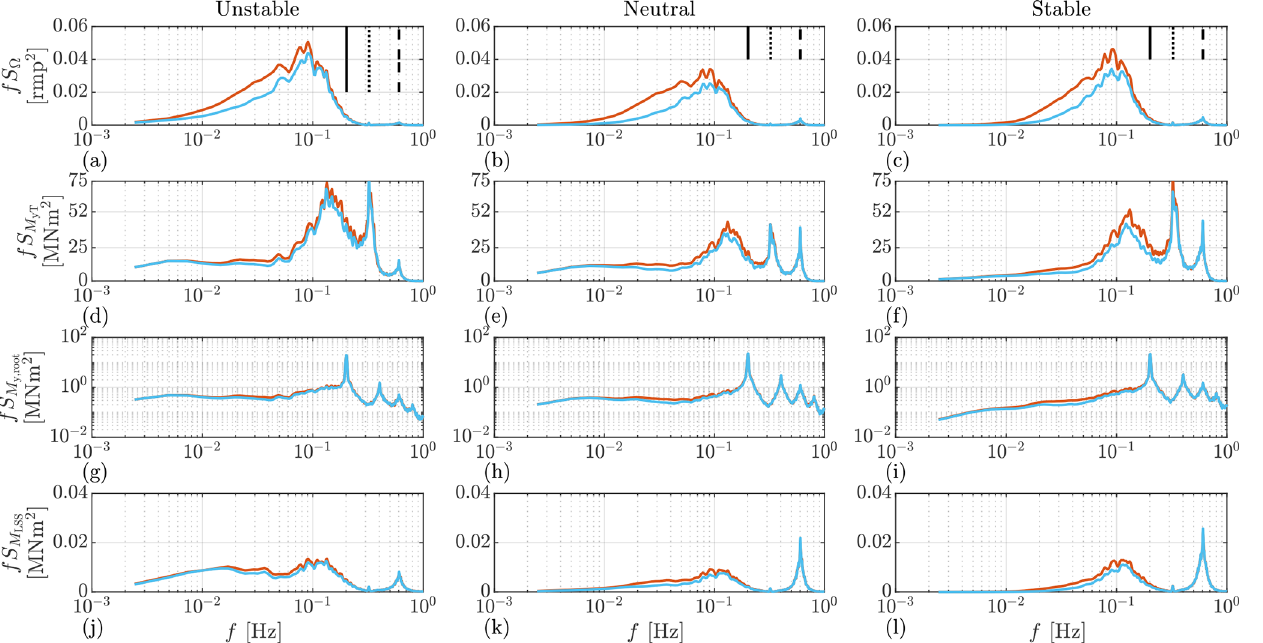
Figure 12. The auto-spectra estimated from OpenFAST output time series. The simulation results are obtained using the Kaimal model. The mean wind speed is 16ms − 1 . Note that the y axis of the blade root bending moment is set to logarithmic for better